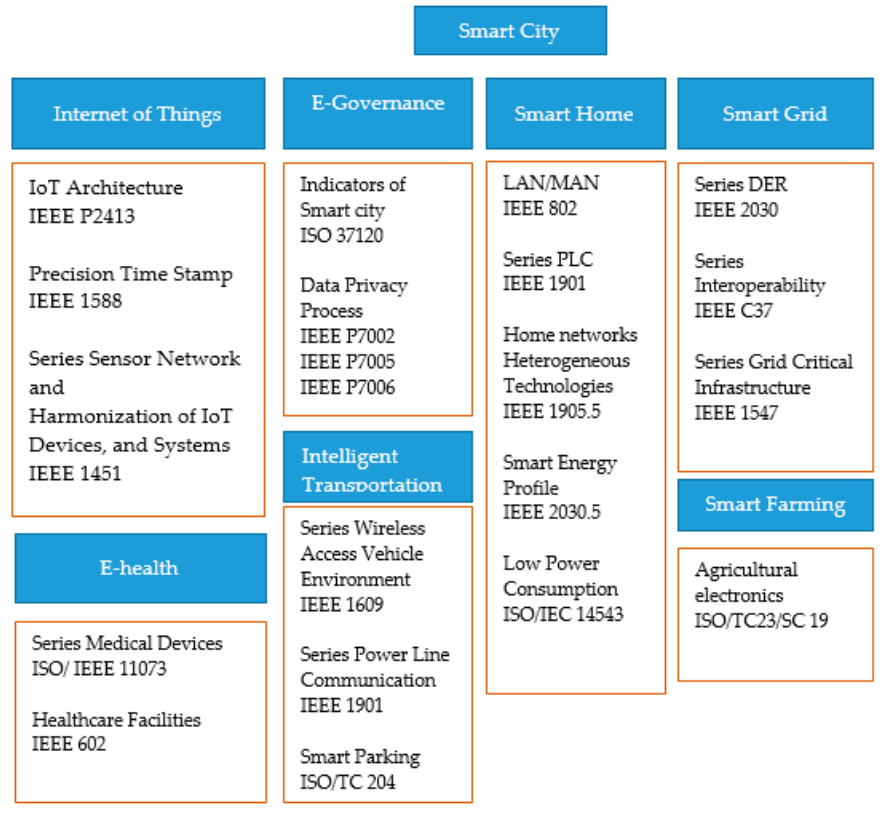
Figure 6. IoT standards for smart city subcategories. IEEE: Institute of Electrical and Electronics Engineers, ISO: International Standardization Organization.